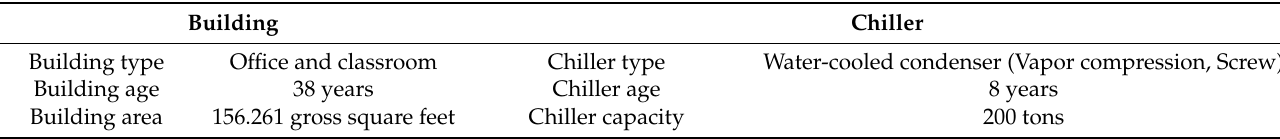
Table 4. Characteristics of the case study building and the